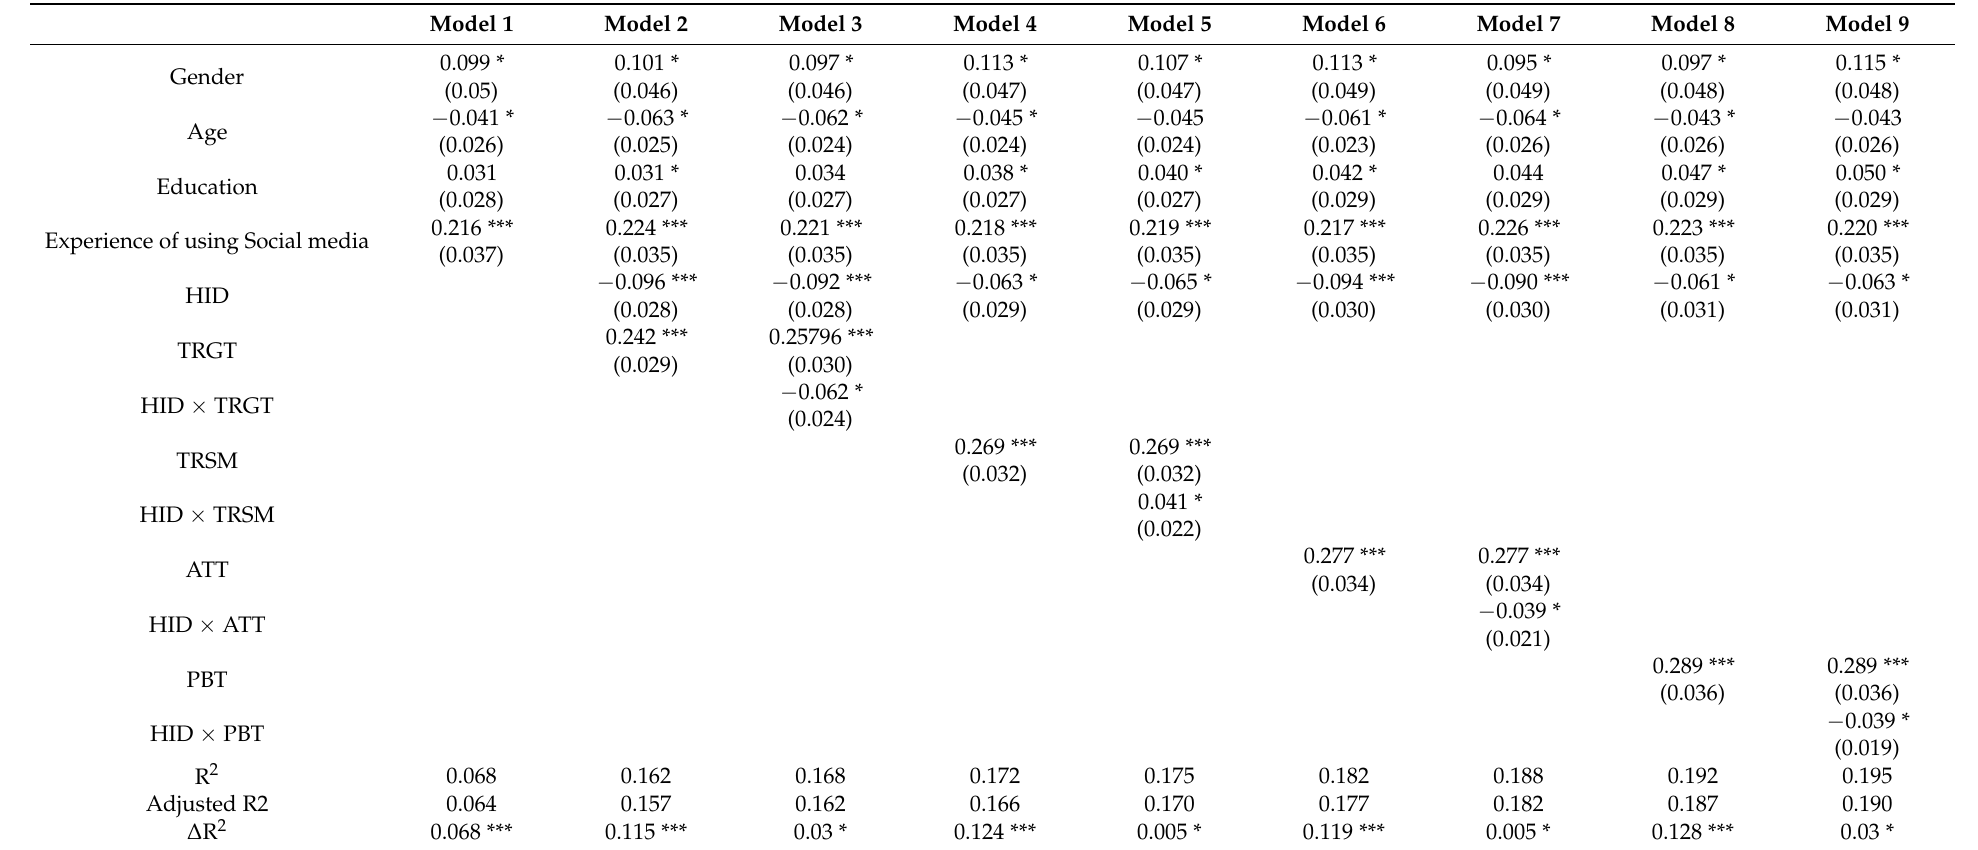
Table 8. The effect of TRGT, TRSM, ATT, and PBT on INT is moderated by health